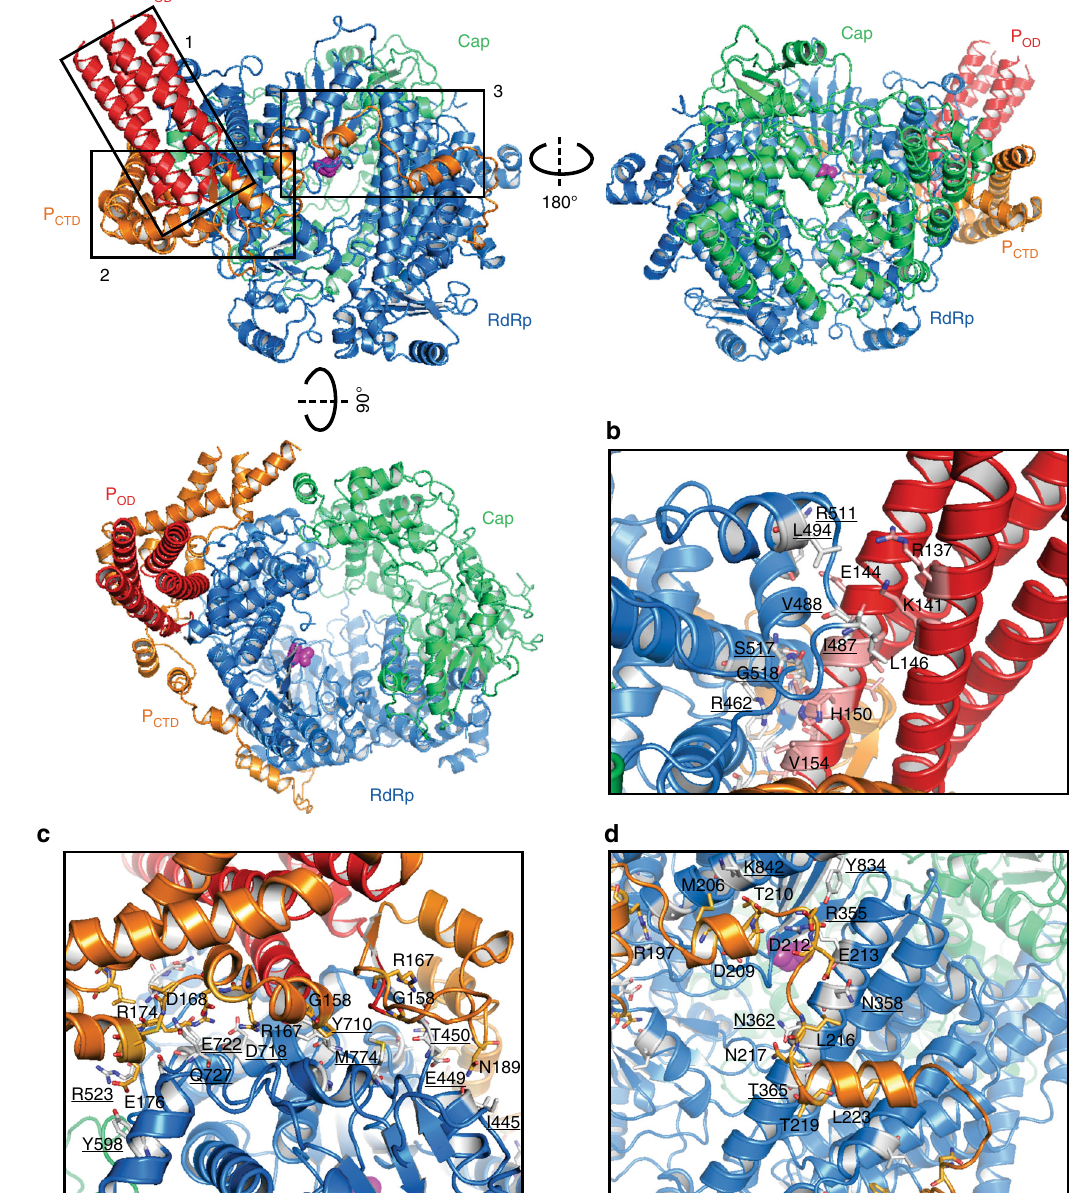
Fig. 2 Cryo-EM structure and interactions of RSV polymerase (L:P). a The cartoon diagrams of RSV polymerase complex is shown in three orientations. Domains are color-coded as in Fig. 1a, and the RdRp active site (D811) is shown in the magenta sphere. The boxes indicate the magni fi ed views of the interactions between L and P. Magni fi ed views of interaction interfaces between the L and P OD ( b ), L and P CTD ( c , d ), and representative residues are shown. The same color scheme for the cartoons and side chains. The interacting residues of L on P are